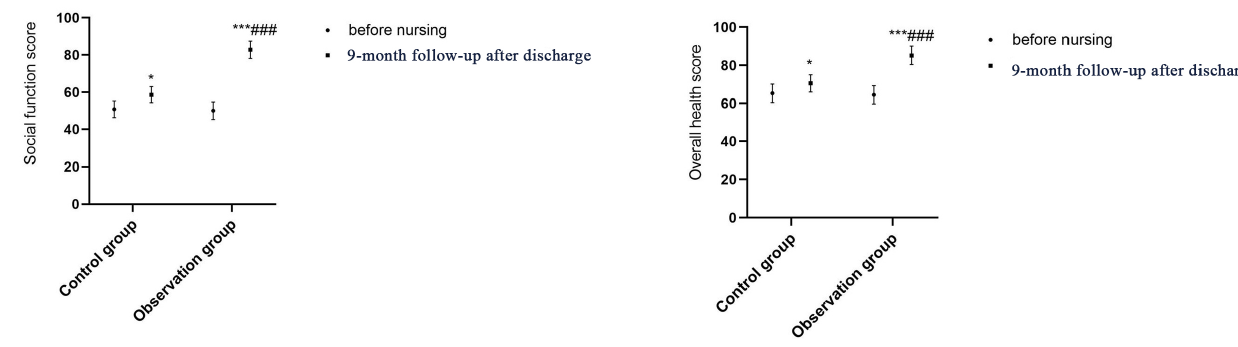
Fig. 3 - Comparison of social function between the two groups before and after continuing care. Compared with on admission within the same group, *P<0.05, ***P<0.001; compared with the control group after continuing care, ### P<0.001.